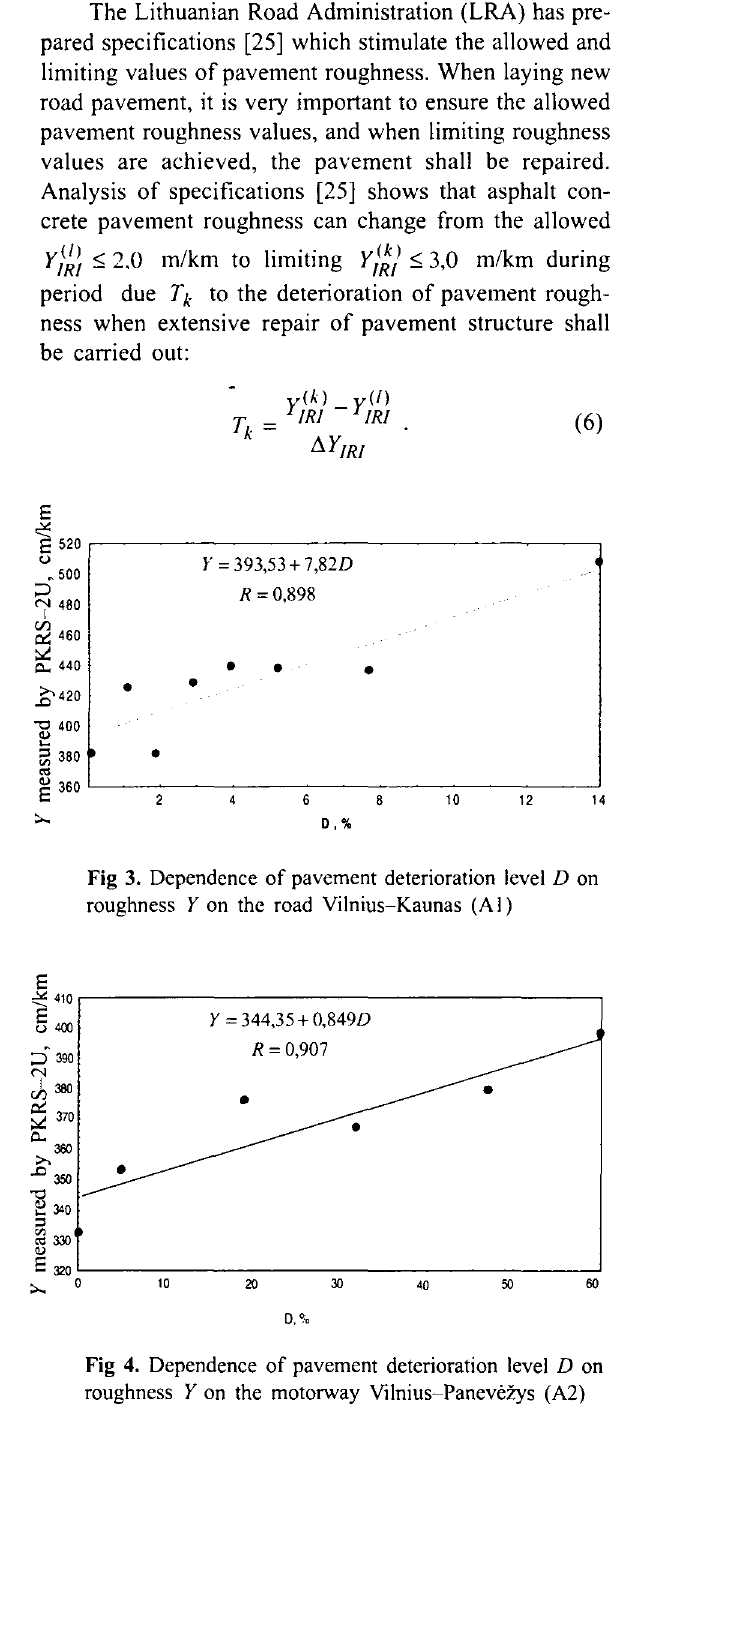
Fig 4. Dependence of pavement deterioration level D on roughness Y on the motorway Vilnius-Panevezys